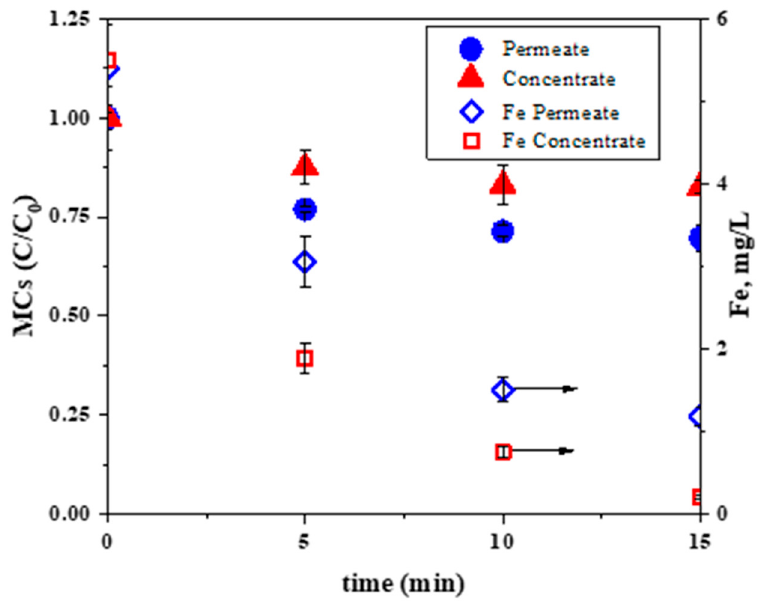
Figure 7. MC concentration ( • : permeate; (cid:78) : concentrate) in the UWWTP effluent during solar photo-Fenton treatment and the evolution of dissolved iron ( ◊ : permeate; □ : concentrate) in the solar simulator, with 0.1 mM Fe:EDDS 1:1 and 1.5 mM H 2 O 2 .